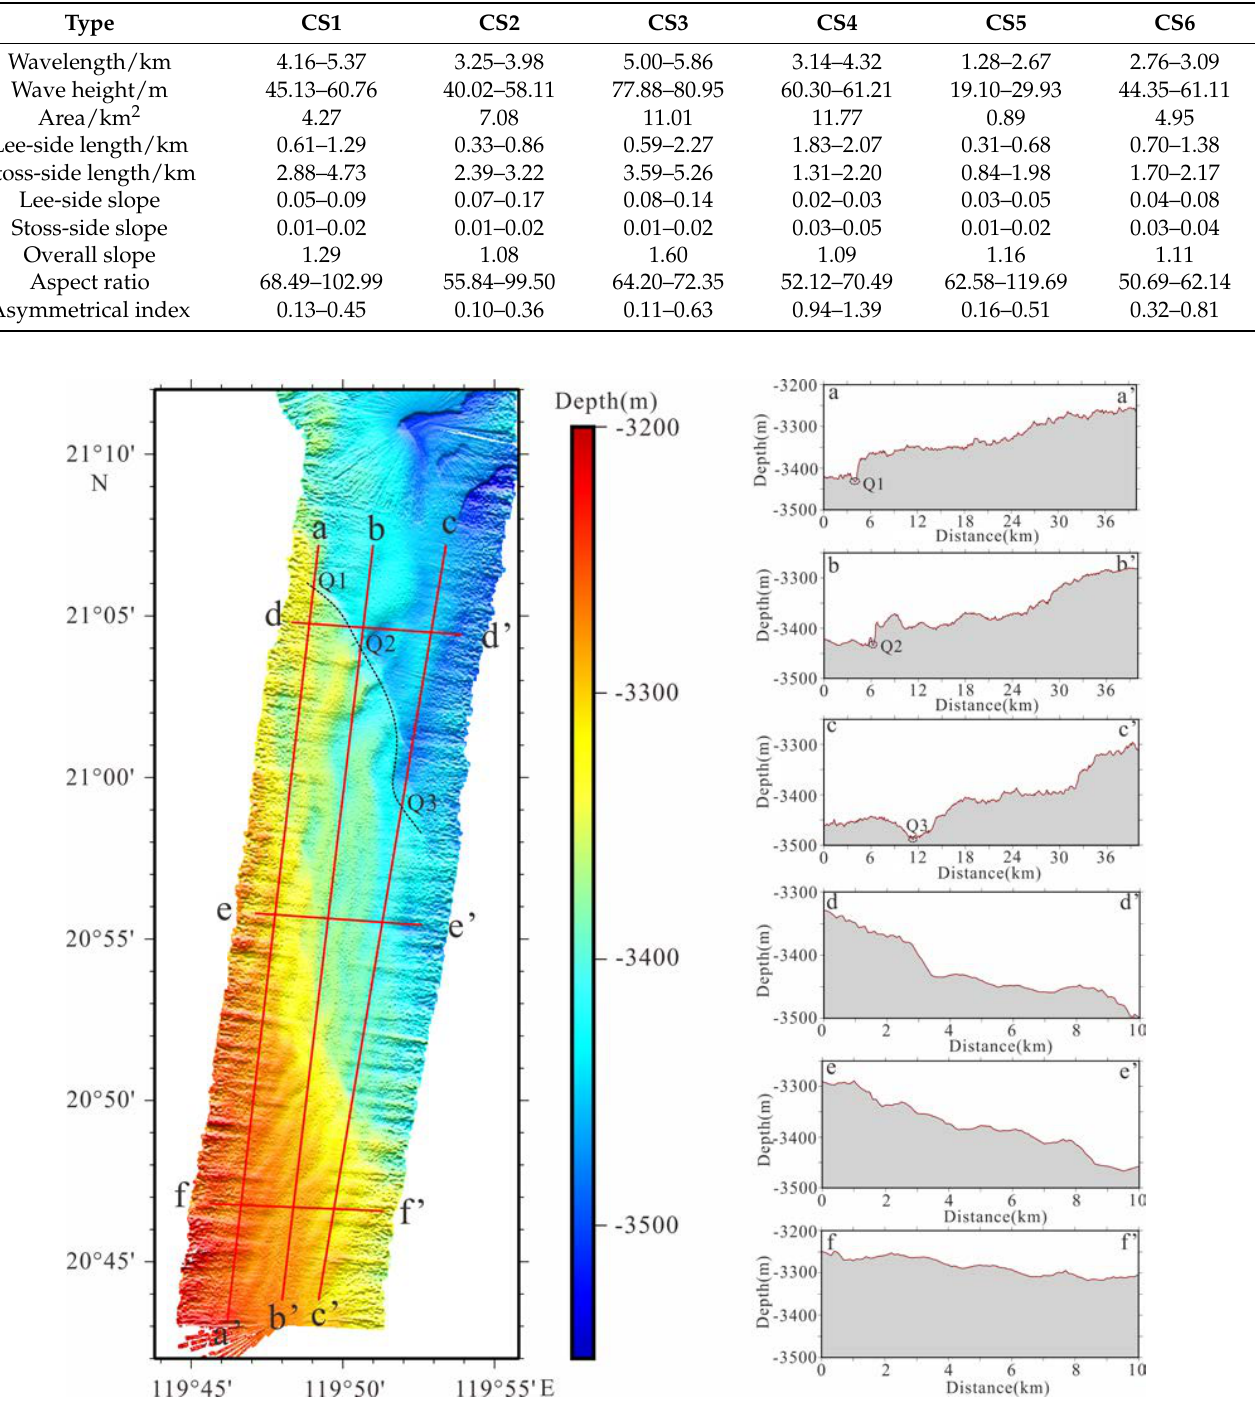
Figure 7. Geometry of sediment wave in the lower section of the Penghu canyon. ( a ) Topographic map of sediment wave from the multibeam bathymetry data. The red lines are the cut sediment wave profiles, and the black dashed lines of Q1 − Q2 − Q3 are bathymetry boundary lines between sediment wave and cyclic steps. ( b − d ) Longitudinal profiles of sediment wave. ( e − f ) Cross-sectional profiles of sediment wave.